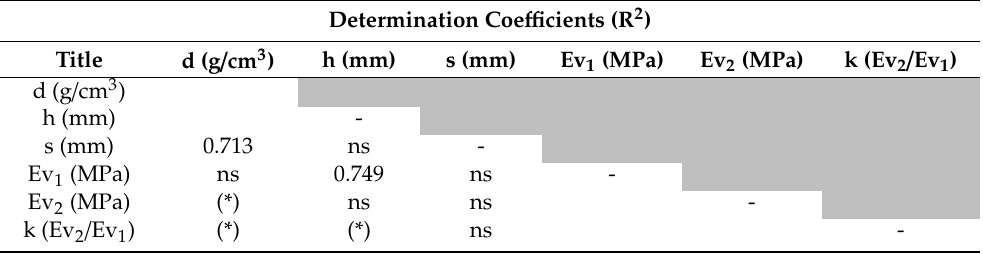
Table 18. Granite rockfill in core significance matrix.